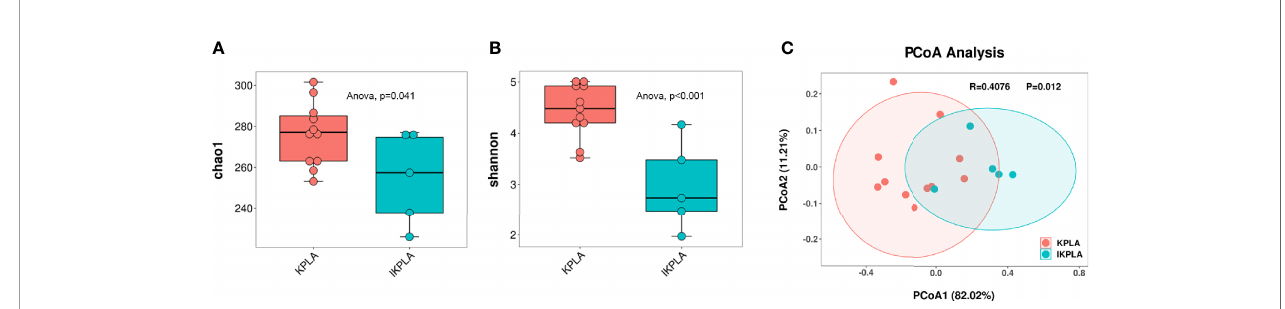
FIGURE 2 | Alpha and beta diversity plots to examine the differences between the groups. Both the Chao1 and Shannon indices in the IKPLA group were lower than those in the KPLA group (A, B) . PCoA analysis based on log transformed metagenomic species abundances (C) . Associated P values < 0.05 were considered as signi fi cant separation between KPLA